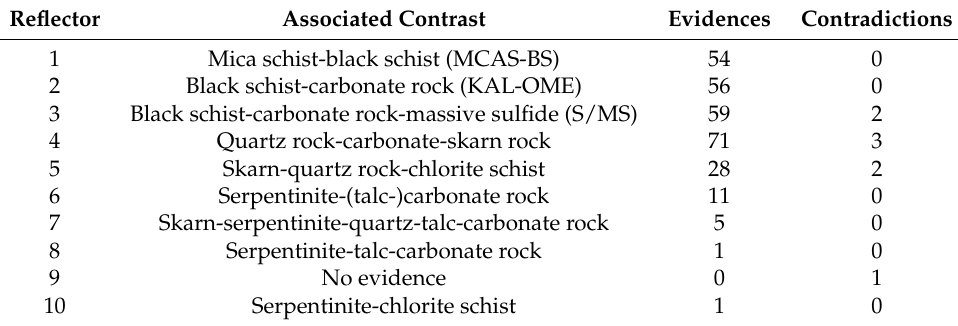
Figure 10. Interpretation of migrated reflection images obtained from all boreholes. The displayed images were obtained from shots SP26 (KU-917 and KU-936B) and SP13 (KU-941). Seismic sources are indicated by green spheres in the mine tunnels. Boxed numbers mark the identified reflections; blue numbers (1–10) are backed up by logging data, whereas gray numbers (11–19) represent new features. Reflector 3 (red) represents the target sulfide lens. Borehole KU-958 was drilled for validation purposes after the initial interpretation was obtained. Table 4. Evidence for identified Reflections 1–10 from 135 borehole logs. Boreholes were used for validation if they intersect or are located closely to a migrated VSP image. If the log contained a lithological contrast within one wavelength of the identified reflection, it was counted as evidence. Otherwise, it counted as a